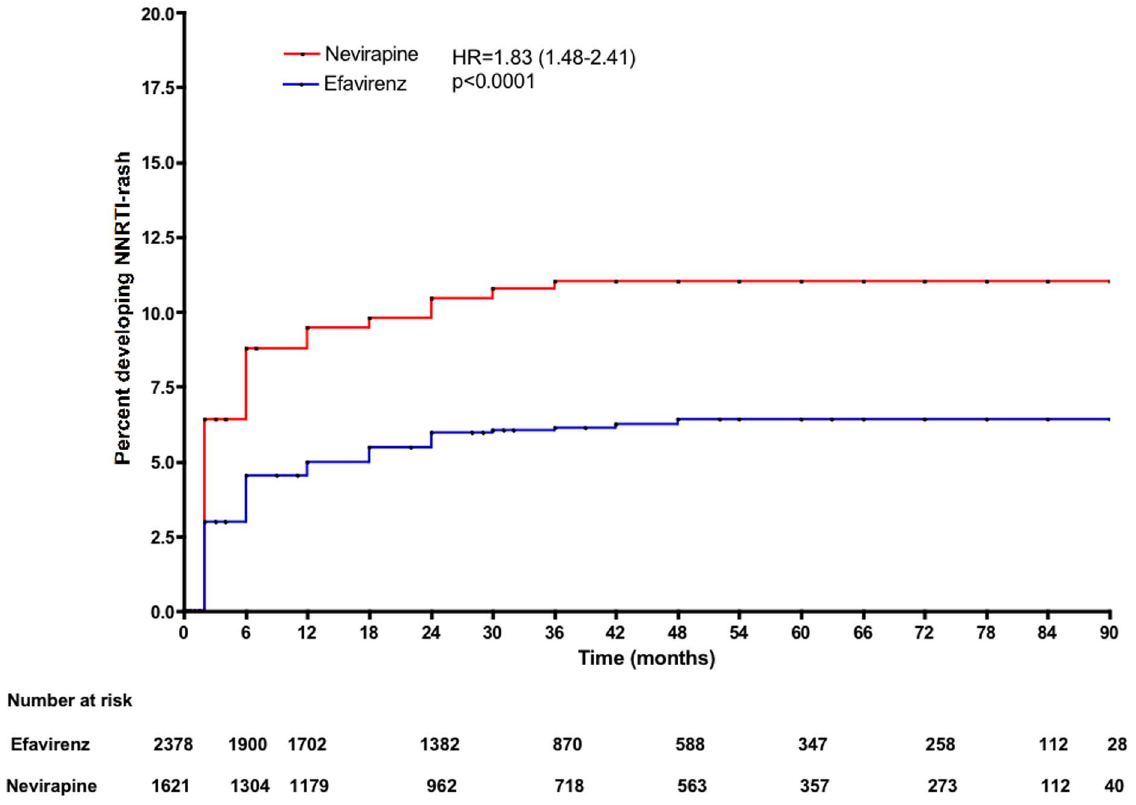
Figure 1. Kaplan-Meier estimates of risk for NNRTI-related skin rash according to NNRTI used.